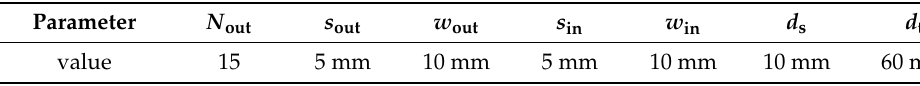
Table 2. Geometric parameters of electromagnetic coupler.